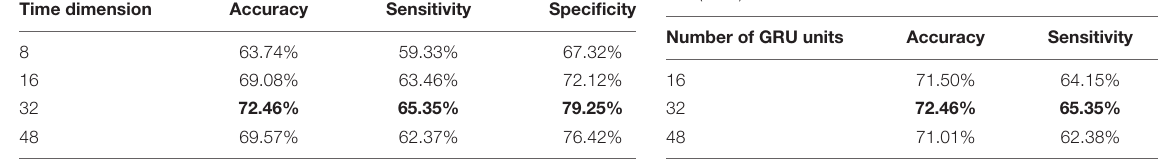
TABLE 6 | Classification performance with different numbers of gate recurrent unit (GRU) units.